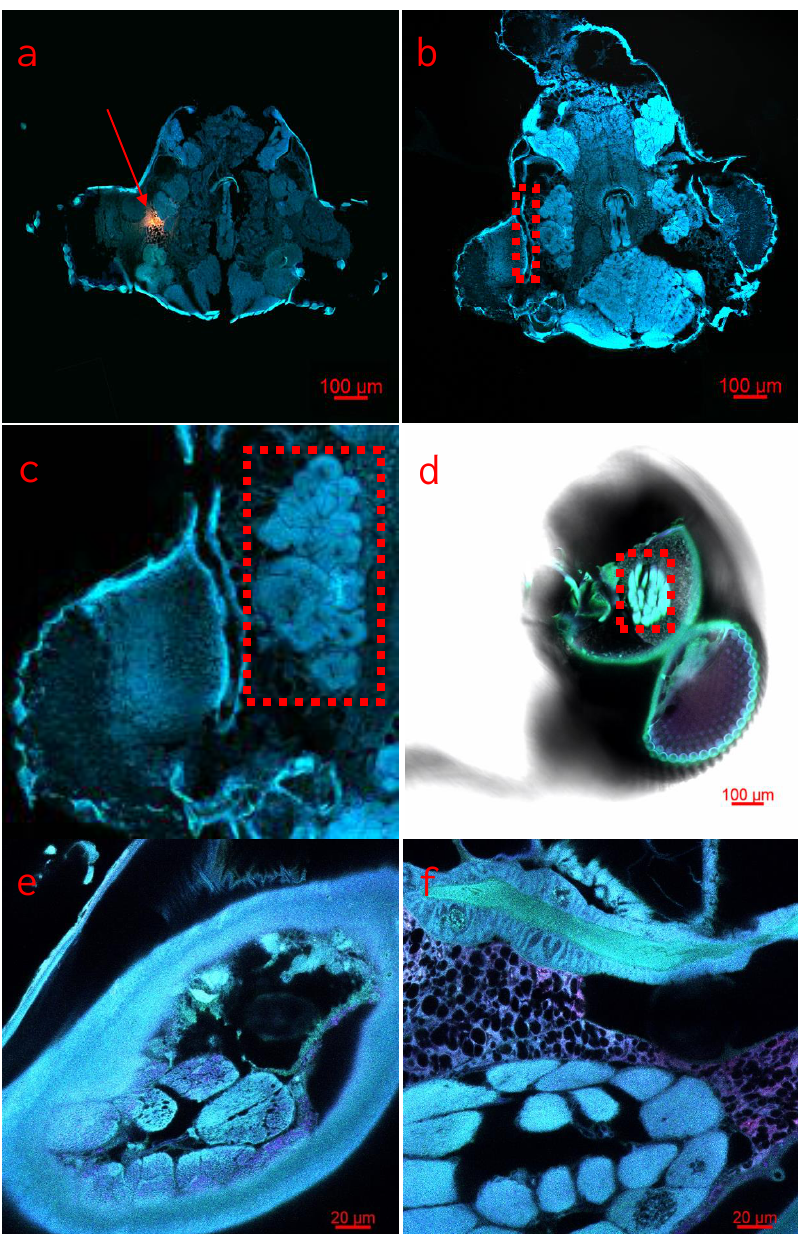
Figure 6. The analysis of the enhanced fluorescence signals in the peripheral antennal lobe. ( a ) The merged fluorescent image of three different fluorescence channels under the bright-field background showed that the fluorescence signals were intensified in the peripheral antenna lobe (The three fluorescence dyes in three channels were excited at 643 nm, 575 nm, 488 nm). The red arrow points to fluorescent signals of PNA probes. The scale bar indicates 100 µ m. ( b ) Non-injected A. lineolatus adults were used as a control. The red box indicates the peripheral of antennal lobe. The scale bar indicates 100 µ m. ( c ) The antennal lobe of A. lineolatus in Fig 6b was amplified. ( d ) After the whole body of A. lineolatus adults were following PEGASOS recirculation procedure, the antennal lobe in the head of A. lineolatus was observed using a Zeiss LSM 880 confocal microscope (10 × ). The scale bar indicates 100 µ m. ( e – f ) Different layers of the antennal lobe observed under using a Zeiss LSM 880 confocal microscope (63 × ). The scale bar indicates 20 µ